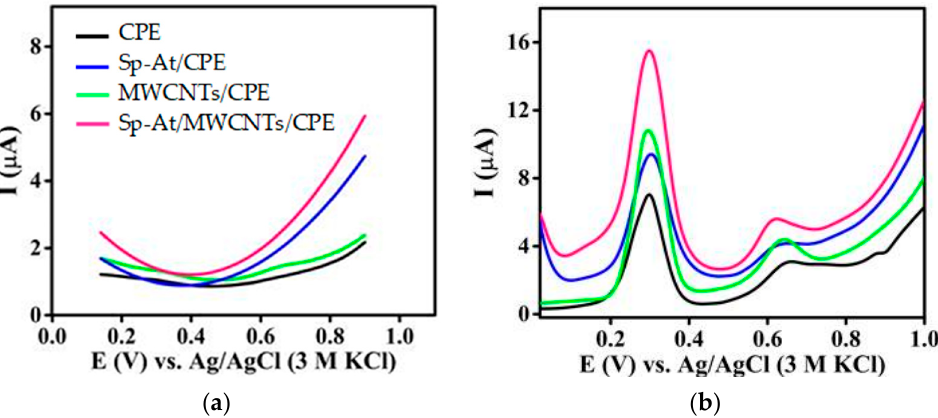
Figure 1. DPVs of CPE, Sp-At/CPE, MWCNTs/CPE, and Sp-At/MWCNTs/CPE in 0.1 M phosphate buffer (pH 4) at a scan rate of 0.1 V ∙ s − 1 in the ( a ) absence of GA and ( b ) presence of 30 μ M GA.